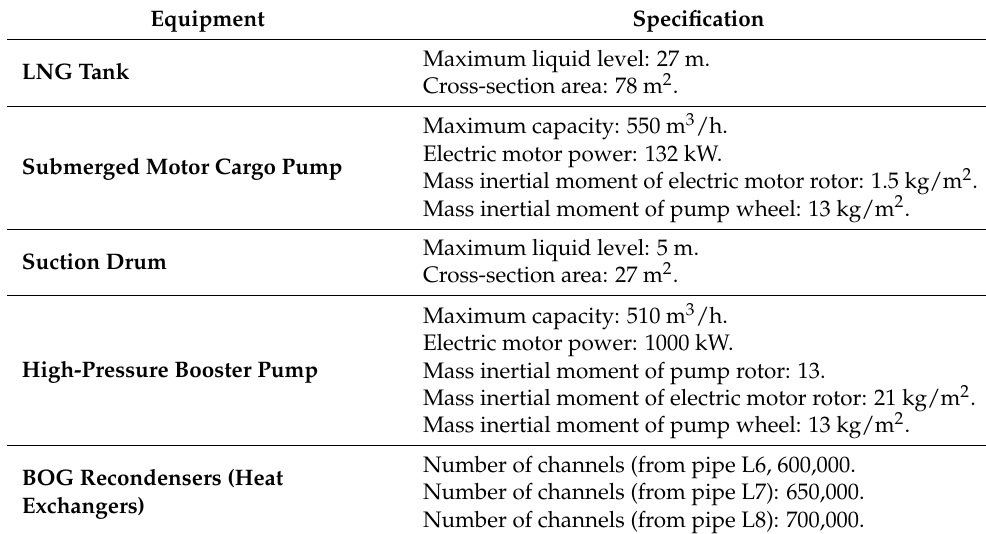
Table 2. Specifications of FSRU